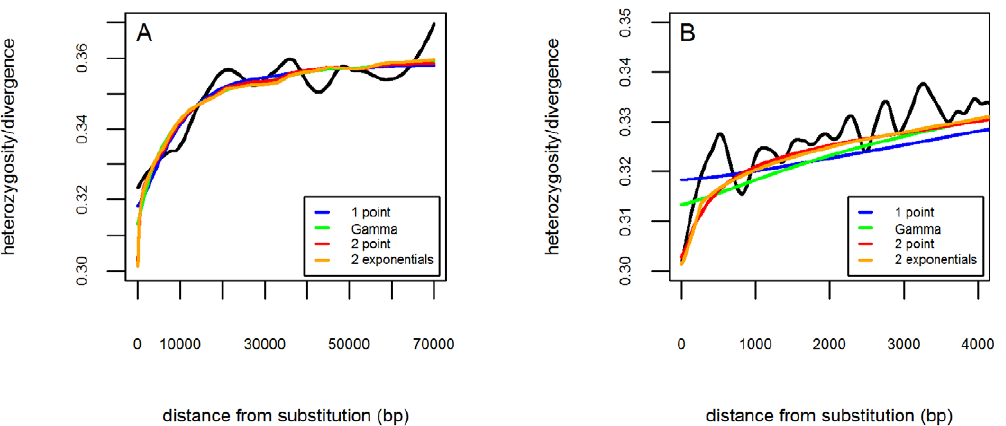
Figure 3. The fit of recurrent selective sweep models to diversity patterns around amino acid substitutions. A. Observed and predicted curves for the average synonymous heterozygosity as a function of distance from amino acid substitutions. The curve based on the data (black) was smoothed using LOESS with a span of 0.5 and divided by divergence, as in Figure 1. The predicted curves correspond to maximum likelihood estimates based on different distributions of beneficial selection coefficients: ‘‘1 point’’ corresponds to a single selection coefficient (blue); ‘‘Gamma’’ to a Gamma distribution (green); ‘‘2 point’’ to two selection coefficients (red); ‘‘2 exponentials’’ to a mixture of two exponentials (orange). B. A close- up on distances up to 4 kb. To reveal more detail of the observed curve on this scale, we used LOESS smoothing with a smaller span of 0.002. See Text S1 for further details.